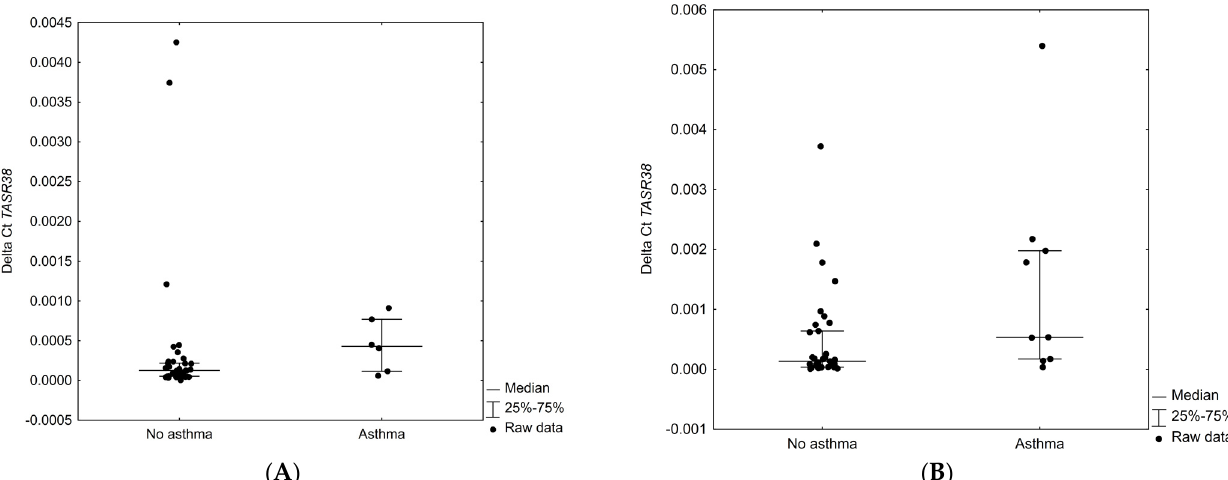
Figure 5. Difference between groups divided according to asthma state in TAS2R38 expression level in inferior turbinate mucosa ( A ) and polyp tissue ( B ).